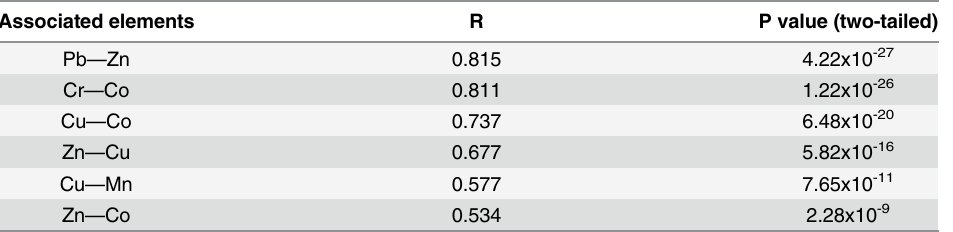
Table 2. Correlation coefficients between geochemical